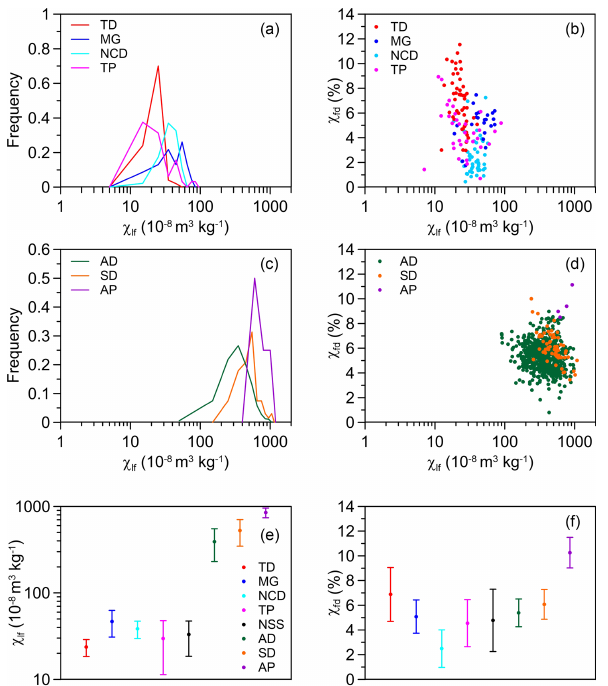
Figure 5. Frequency distribution of χ lf (a, c) , bivariate plots of χ lf versus χ fd (b, d) , and average values and standard deviations of χ lf and χ fd (e, f) for NSS in each source and in urban dust aerosols, including AD, STD, and AP. Frequency distribution statistics of χ lf for NSS, AD and STD, and AP are generated using intervals of 10 × 10 − 8 m 3 kg − 1 , 100 × 10 − 8 m 3 kg − 1 , and 200 × 10 − 8 m 3 kg − 1 , respectively.